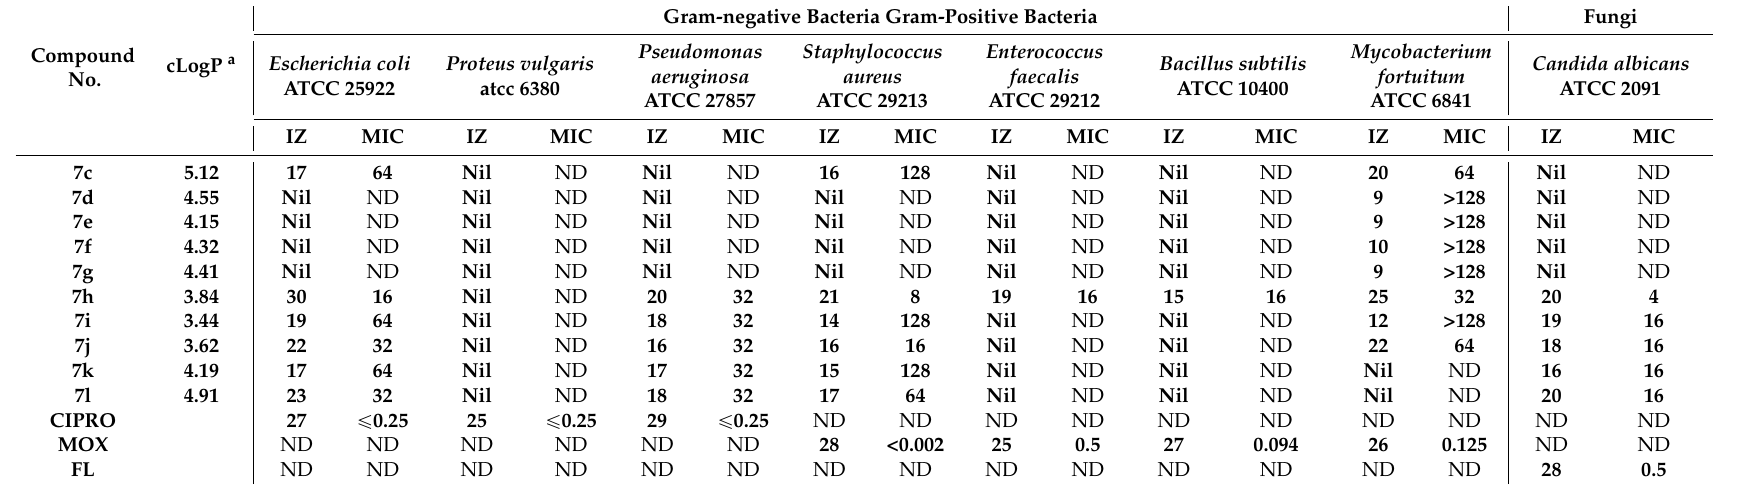
Table 1. In vitro antimicrobial activity of the test compounds using the inhibition zone (IZ) and MIC.